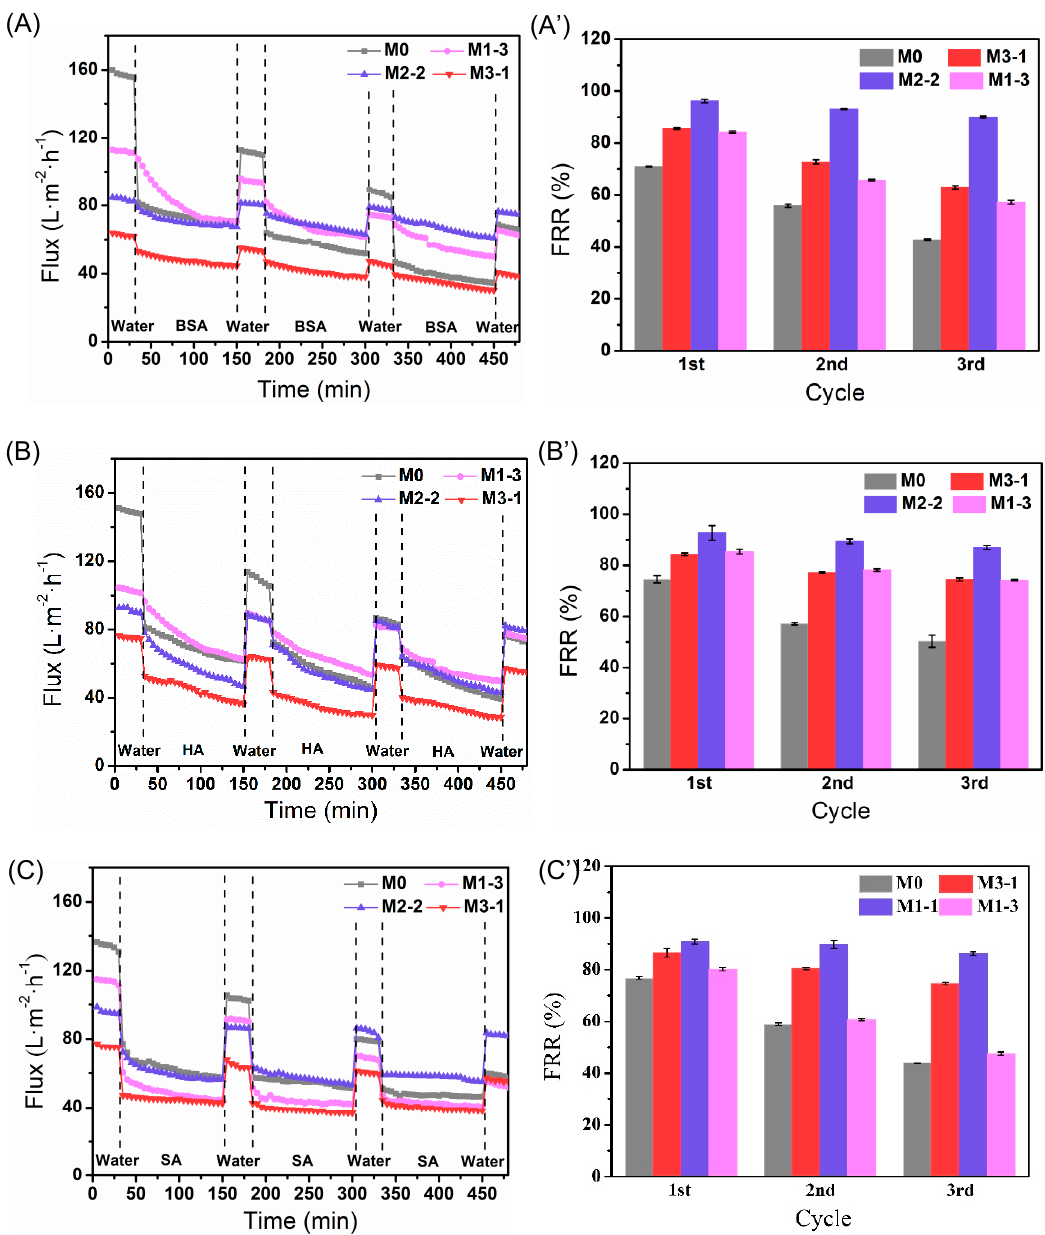
Figure 8. Time-dependent flux of three recycles of membranes for ( A ) BSA, ( B ) HA, and ( C ) SA; and the corresponding flux recovery ratio (FRR) for ( A’ ) BSA, ( B’ ) HA, and ( C’ ) SA, respectively.